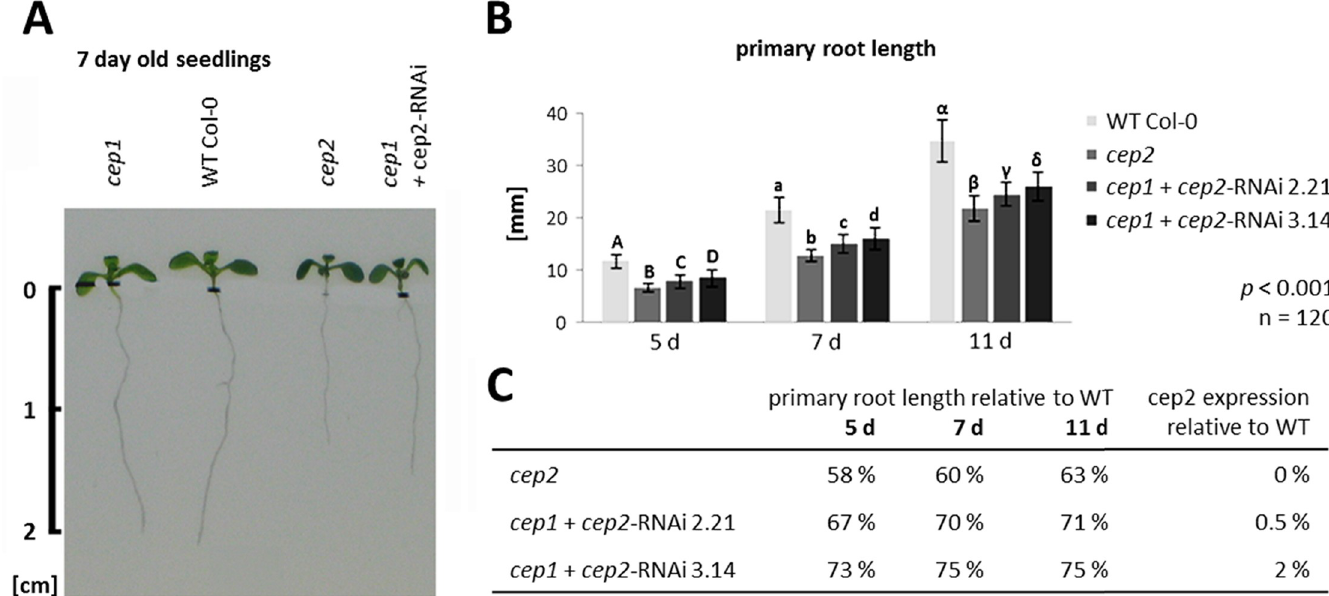
Fig 1. Loss of CEP2 function results in shortened primary roots. Residual CEP2 activity in CEP2 knock down plants results in longer roots as compared to cep2 knock out plants, but shorter as compared to WT. (A) Primary root length in seven days old seedlings of homozygous cep1 ko, cep2 ko and of cep1 cep2 double ko/kd mutants ( cep1 + cep2- RNAi) versus Col-0 WT plants. cep2 ko mutants exhibited shorter primary roots compared to Col-0 WT plants. Loss of CEP1 has no influence on primary root length. Residual CEP2 activity (0.5–2% compared to WT) in cep1 cep2 double ko/kd plants resulted in primary roots significantly longer than cep2 ko mutants but shorter than WT plants. Root length is shown in cm. (B) Comparison of primary root length in 5, 7 and 11 days old seedlings of homozygous cep2 ko plants and cep1 cep2 double ko/kd mutants ( cep1 + cep2- RNAi) with a residual CEP2 activity of 0.5% (line 2.21) and 2% (line 3.14) as compared to WT (100% activity). Columns marked with different letters indicate statistically different groups according to the ANOVA-and Duncan test ( p < 0.001). (C) Primary root length expressed as percentage of WT plants. Data represent the respective means of two independent experiments (biological replica) each comprising 120 plants per line.